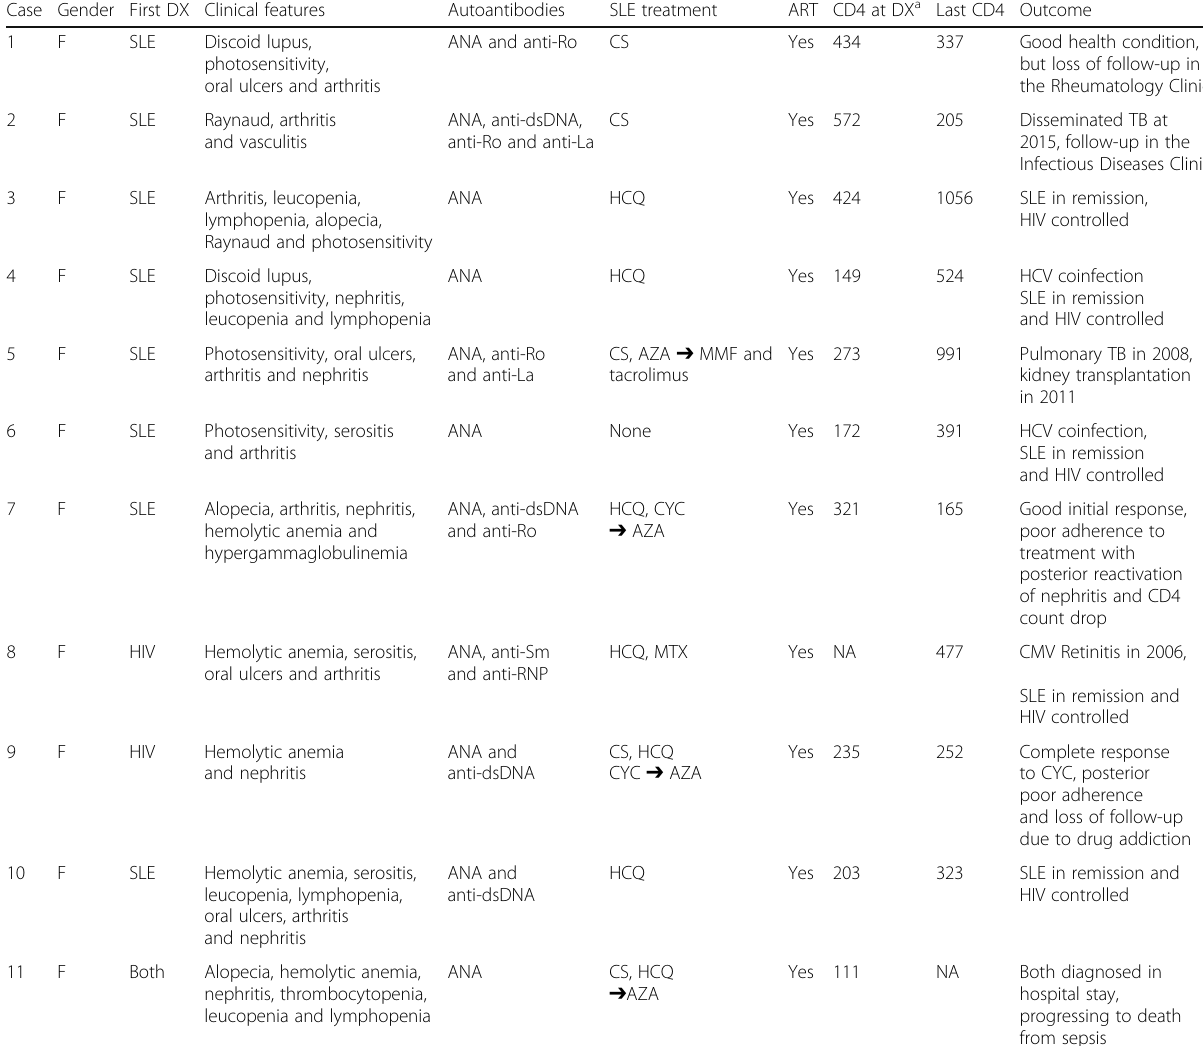
Table 2 Demographic, clinical and laboratory features, treatment and outcome of SLE patients with HIV Case Gender First DX Clinical